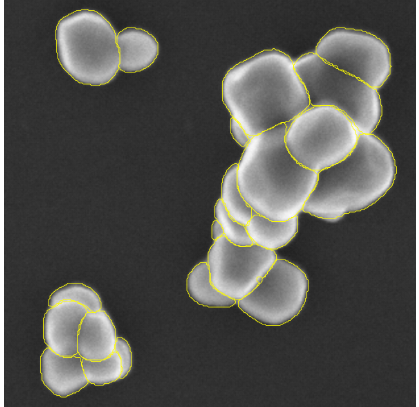
Figure 10. Predicted segmentation over SEM image of scattered TiO 2 particles, zoom ×